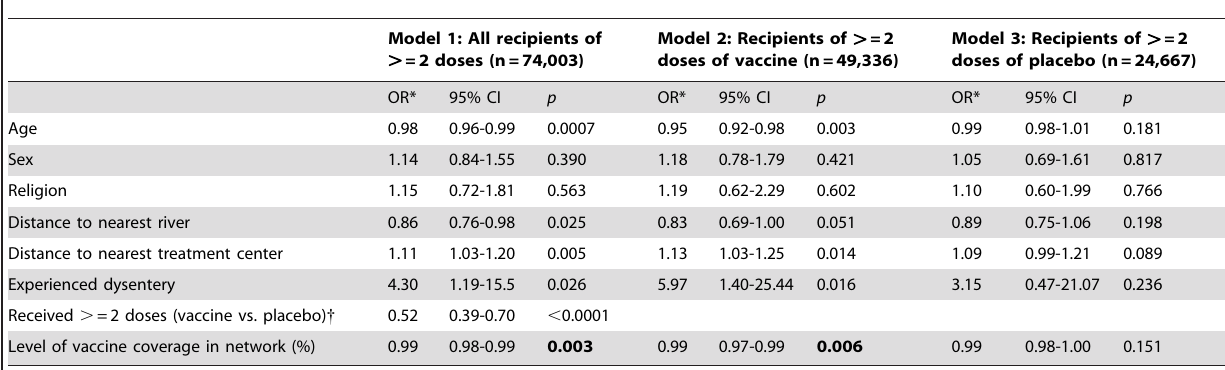
Table 1. Predictors of cholera risk in recipients of vaccine or placebo, household-level social networks.